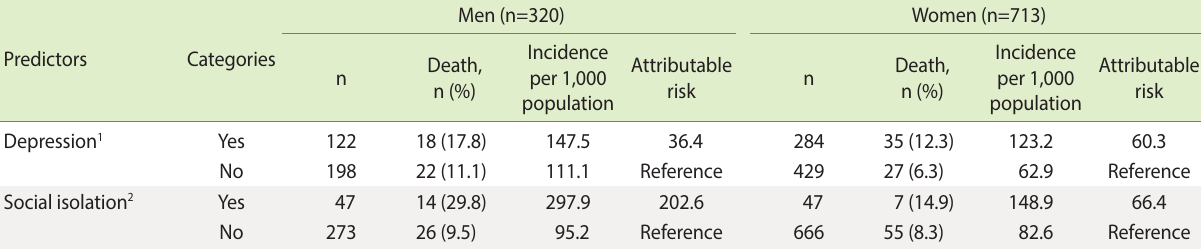
Table 2. Two-year mortality rates according to baseline depression and social isolation in men and women